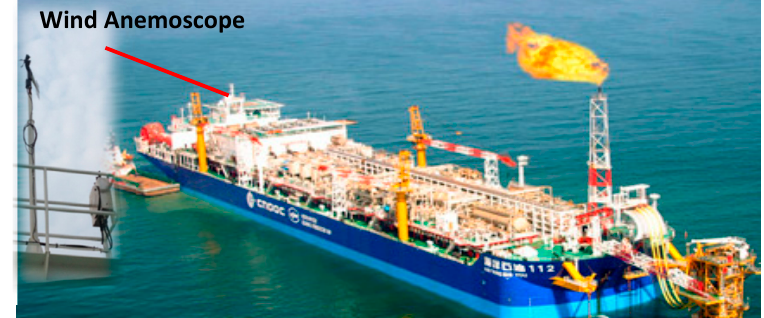
Figure 1. Measuring apparatus and its surrounding environment.